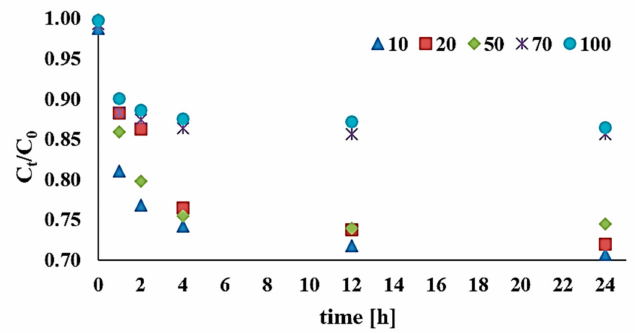
Figure 5. Influence of initial content (C 0 = 10–100 mg / kg d.w.) on DEHP decomposition via a modified Fenton process (H 2 O 2 :Fe 3 + 1:1, pH